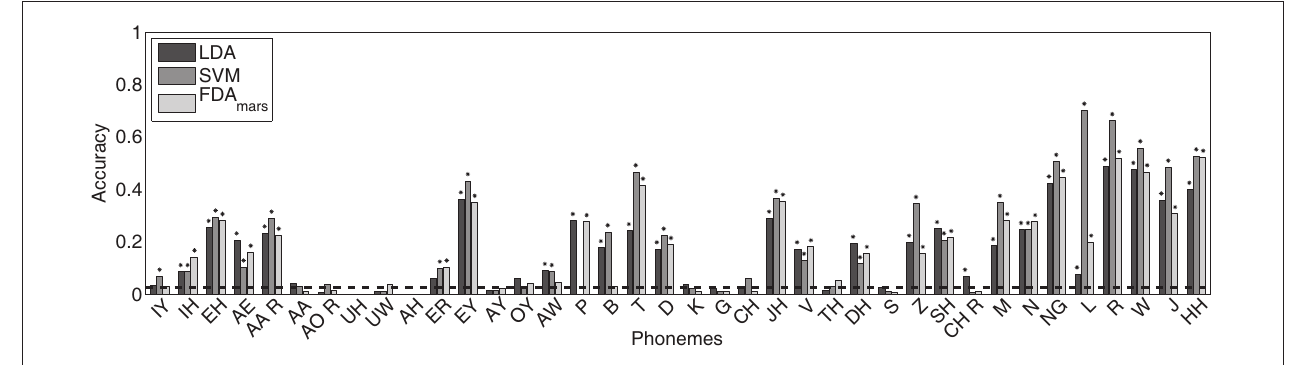
Figure 4 | The classification accuracy for each phoneme using the LDA, SVM, and FDA classifiers is shown with the theoretical chance performance level (dashed line, ∼ 1/38). Phonemes with classification rates statistically above chance (binomial test, Bonferroni-adjusted p < 0.05) are marked with an asterisk (*). Twenty of 38 phonemes were classified above chance for all methods, and 24 phonemes for at least two of the three classification methods and 26 phonemes for